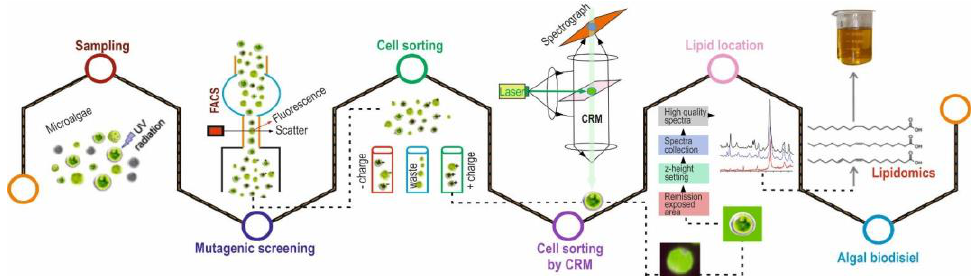
Figure 7. The schematic view in lipid characterisation of microalgae. Bioprospecting of C. reinhardtii is performed to generate algal samples with lipid content. The mutagens are sorted by FACS based on the fluorescence of a dye to select cells with high lipid content. The selected cells and mutants are then screened using CRM. This method allows for rapid characterisation of lipids. The spectra yield depends on the number of C=C bonds and the length of the hydrocarbon chains of the lipid molecules. This workflow enables rapid characterisation of cells for molecular traits that are important for the production of biodiesel. Modified from Sharma et al [18].